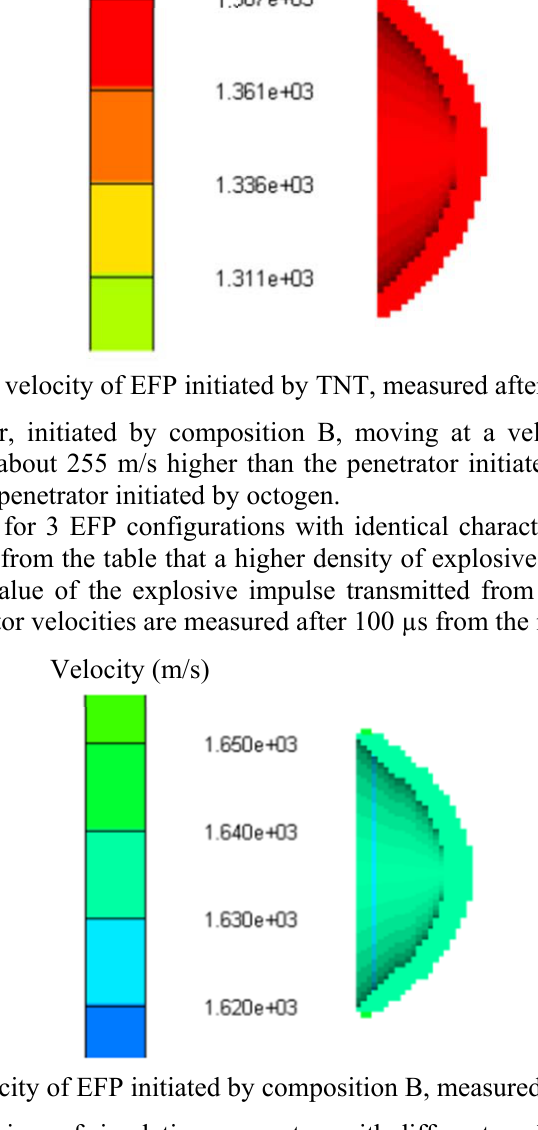
Table 2. Comparison of simulation parameters with different explosive charges [8] Simulation